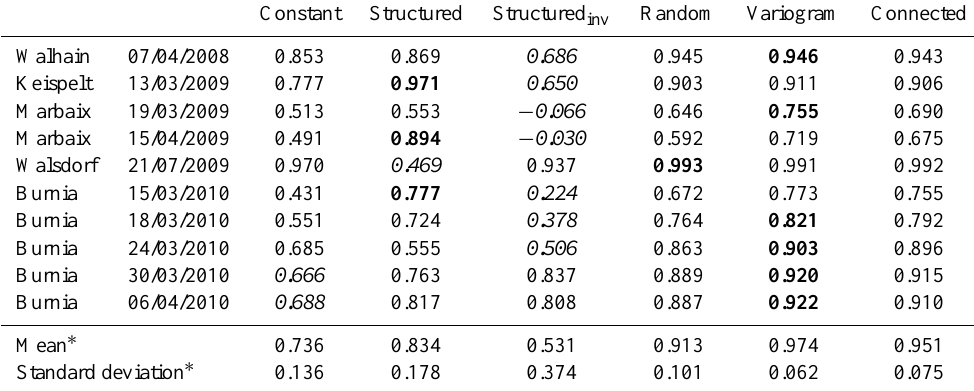
Table 4. Nash-Sutcliffe efficiency coefficients of the different scenarios of antecedent soil moisture maps compared to the Reference scenario for the 10 field campaigns. The mean and the standard deviation of normalised Nash-Sutcliffe coefficients were computed for the 10 field campaigns. Maximum and minimum values for each field campaign are highlighted in bold and italic, respectively.